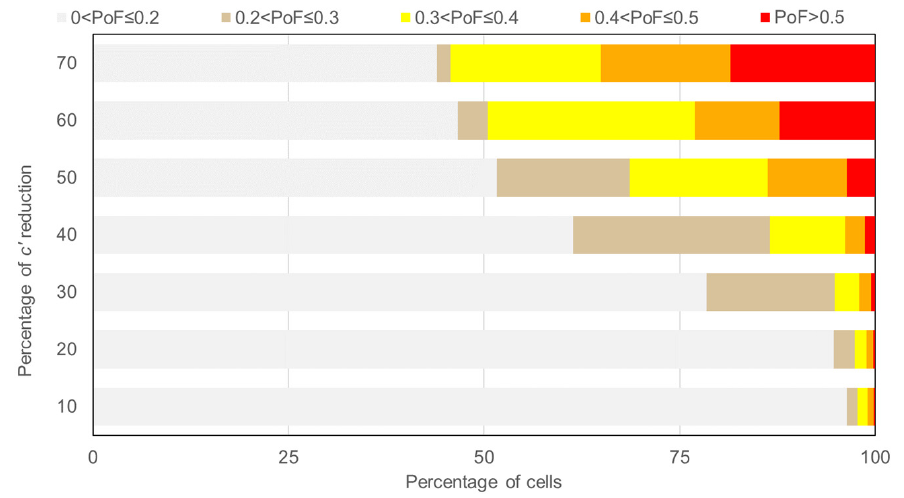
Figure 8. Pixel distribution in the five classes of PoF, according to the different reductions of c ′ .